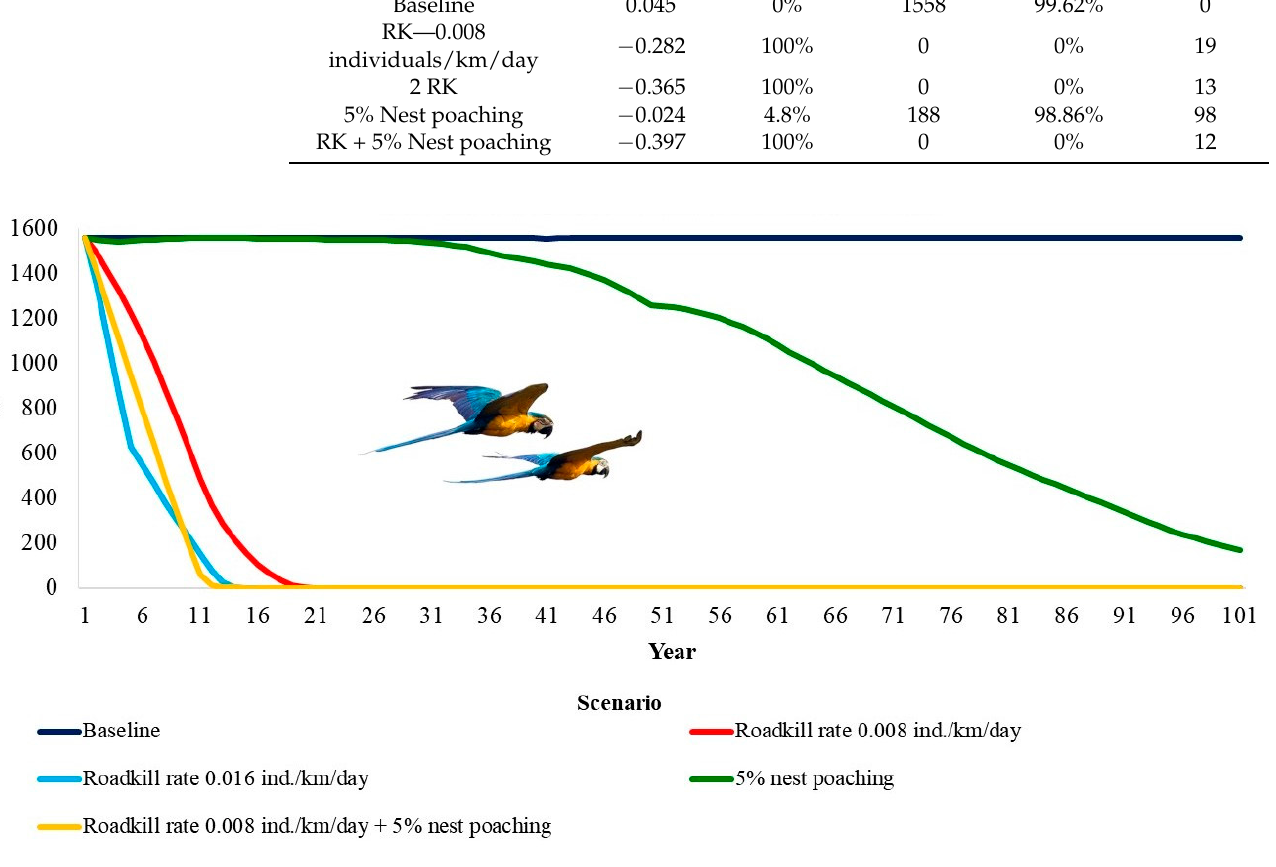
Figure 2. Time to extinction of the blue-and-yellow macaw, Ara ararauna (Aves: Psittaciformes) in Emas Natural Park, Brazil, under the impacts of roadkill and nest poaching. Table 4. Results of minimum viable population for blue-and-yellow macaw ( Ara ararauna ) in Emas National Park, Brazil, suffering from different levels of roadkill (RK) and nest poaching. Stoch_r: mean rate of stochastic population growth, PE: probability of extinction, N-extant: population size at the end of simulations, GeneDiv: genetic diversity, meanTE: mean time to